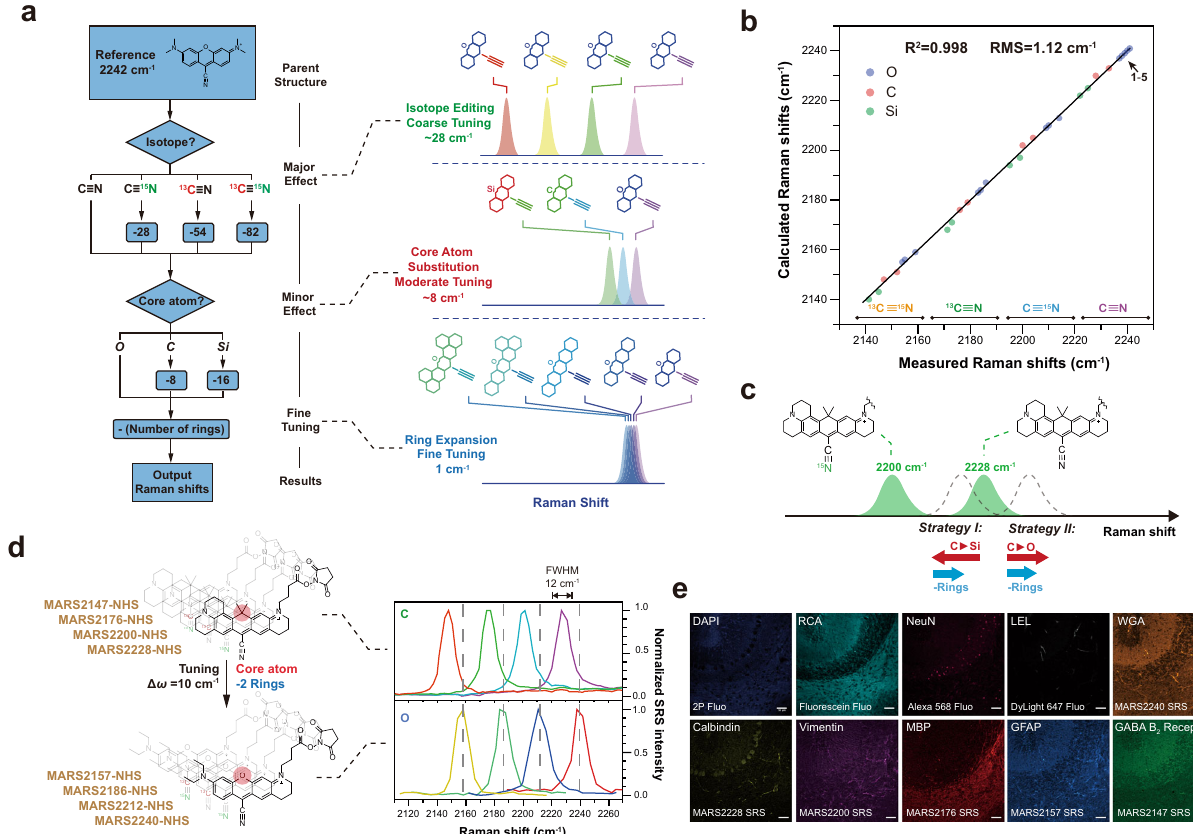
Fig. 3 Super-multiplexed optical imaging with new MARS probes generated by precise prediction. a Flow chart used to estimate Raman shifts of MARS dyes. Starting from the reference structure, three layers were used to modify the expected Raman shifts: isotope doping, core atom substitution, and ring expansion. The three effects can be used to precisely control Raman shifts of nitriles. b Linear fi tting of calculated Raman shifts versus measured Raman shifts. The good linearity and RMS indicate the precision of the propose prediction method. c Schematic illustration of two possible strategies to generate new MARS probes that have resolvable frequencies with MARS2200 and MARS2228 . Combining core atom substitution and ring expansions can both tune the probe away but the two effects in strategy I unfortunately work in opposite direction, resulting in crosstalk with MARS2228 . d Structures of four new MARS NHS esters designed to be compatible with MARS2228 series. The measured Raman shifts exactly matched the predicted Raman shifts and the compounds were named accordingly. Top: epr-SRS spectra of MARS2228 series. Bottom: epr-SRS spectra of MARS2240 series. The two groups of four peaks are evenly spaced to fi t into each other, showing good spectral resolvability. e Simultaneous 10-target imaging on mouse cerebellum thin sections. Fluorescence: DAPI (total DNA), RCA (Ricinus Communis Agglutinin I-FTIC), NeuN (rabbit, Alexa568), LEL (Lycopersicon Esculentum lectin Dy- Light 647). SRS: WGA ( MARS2240-WGA ), Calbindin (mouse, MARS2228 ), Vimentin (chicken, MARS2200 ), MBP (myelin basic protein,